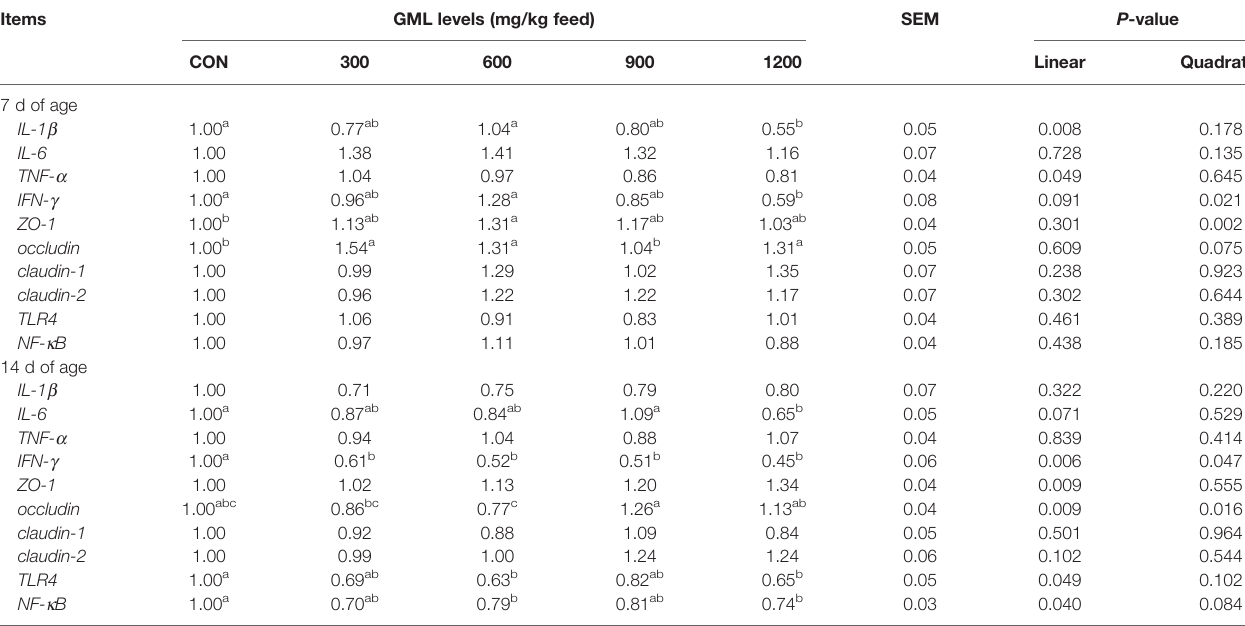
TABLE 6 | Effects of dietary treatment on jejunal gene expression of 7- and 14-day-old